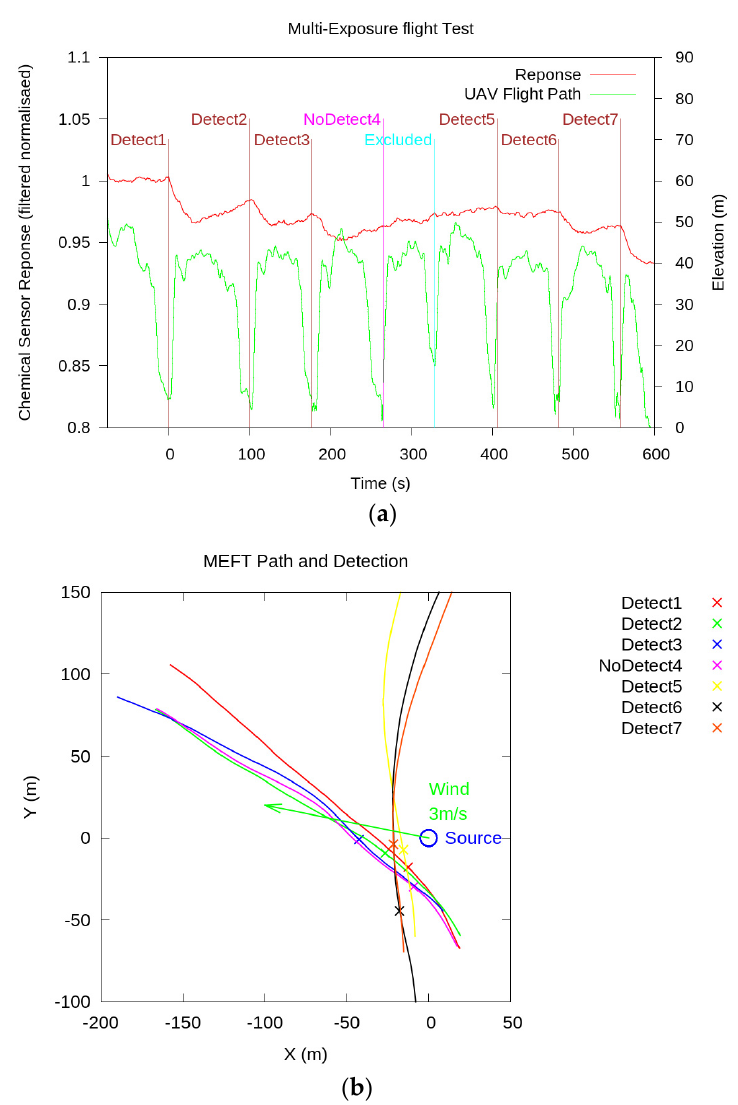
Figure 8. MEFT results ( a ) the time domain sensor response and elevation profile of the UAV; and ( b ) UAV flight trajectory during seven detection passes of the MEFT.